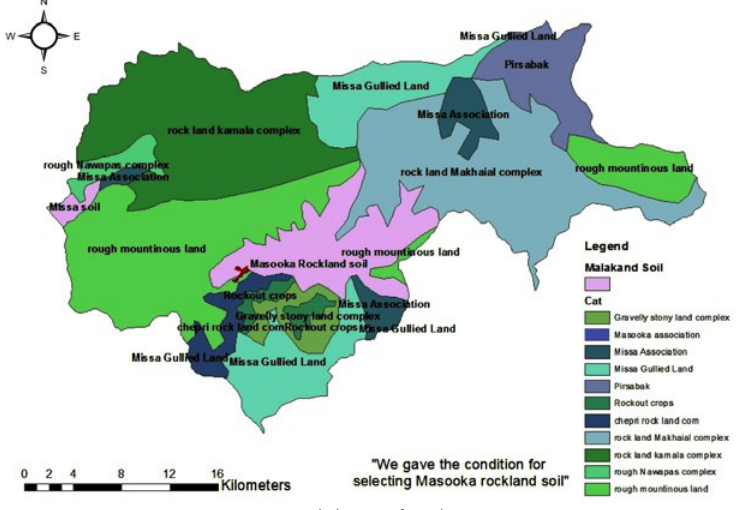
Fig. 2. Soil classes of study area Fig. 2: Soil classes of study area